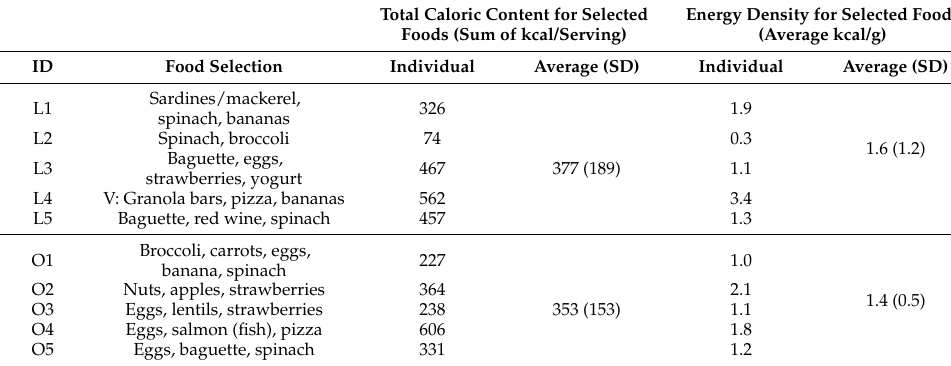
Table 2. Food preferences, caloric content and caloric density from food photo exercise conducted during French